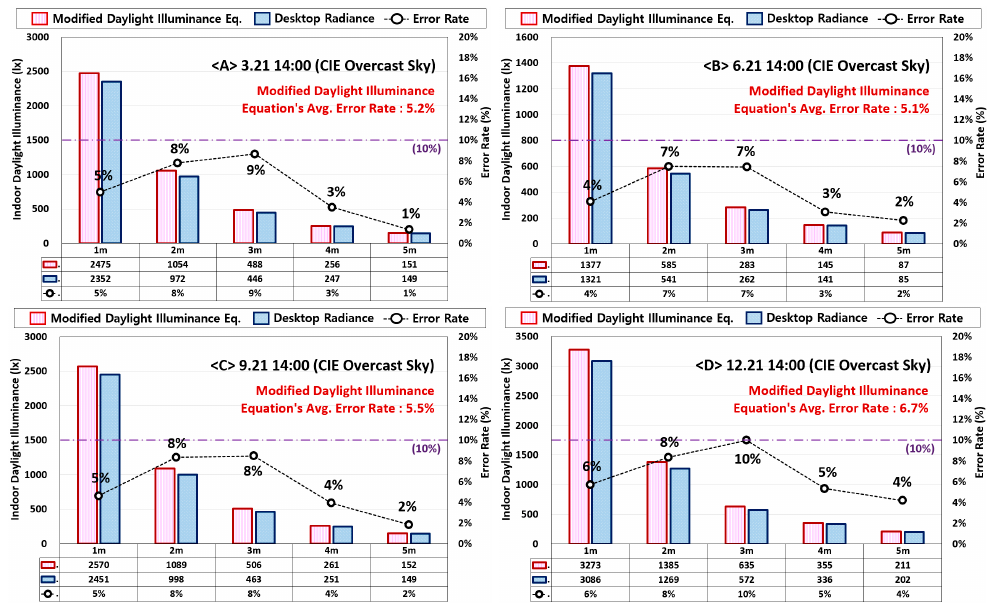
Figure 11. Comparison of indoor daylight illuminance between the modified equation and Desktop Radiance in CIE overcast sky condition ( A ) 3.21, 14:00 ( B ) 6.21, 14:00 ( C ) 9.21, 14:00 ( D ) 12.21, 14:00.